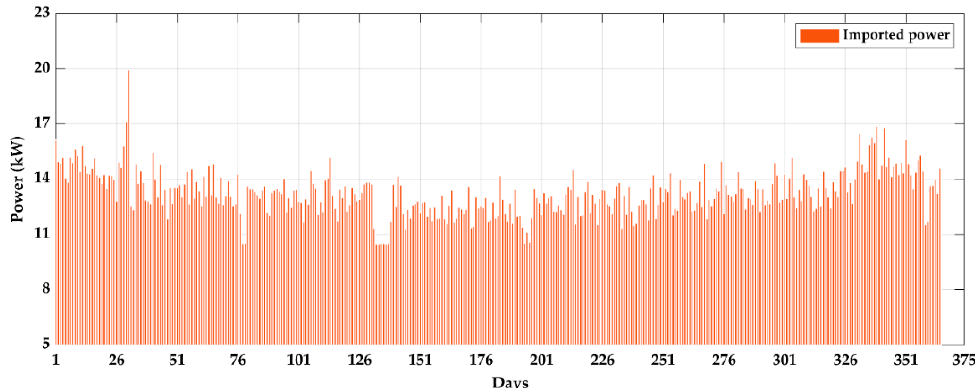
Figure 6. Power purchased from the grid.